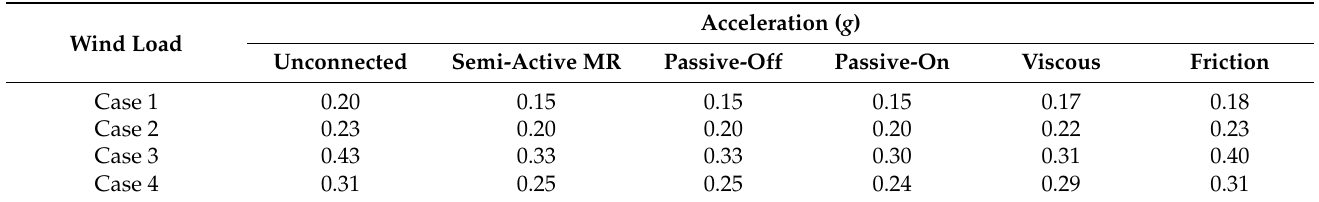
Table 11. Comparison of top storey peak acceleration of the coupled stiff building under different control strategies when dampers are arranged in Configuration 1.